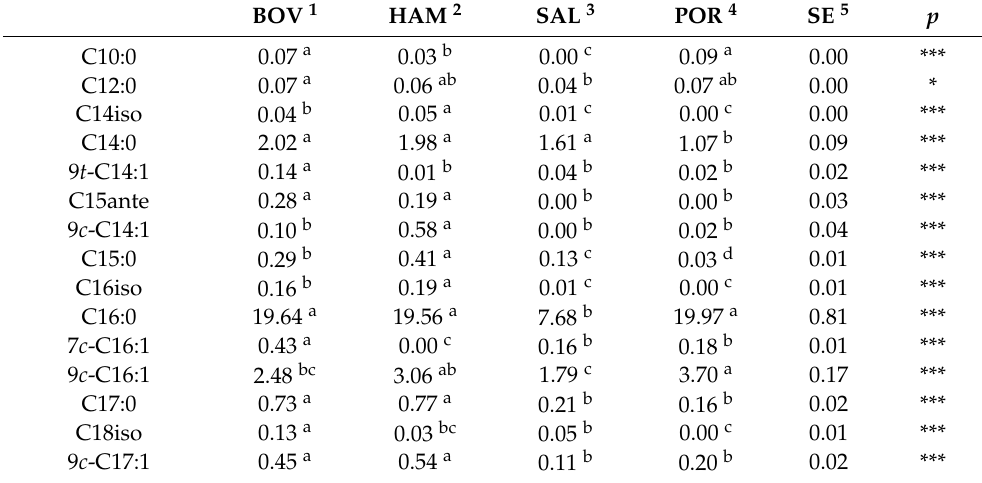
Table 4. Fatty acid composition of raw samples (g/100 g of TL). BOV